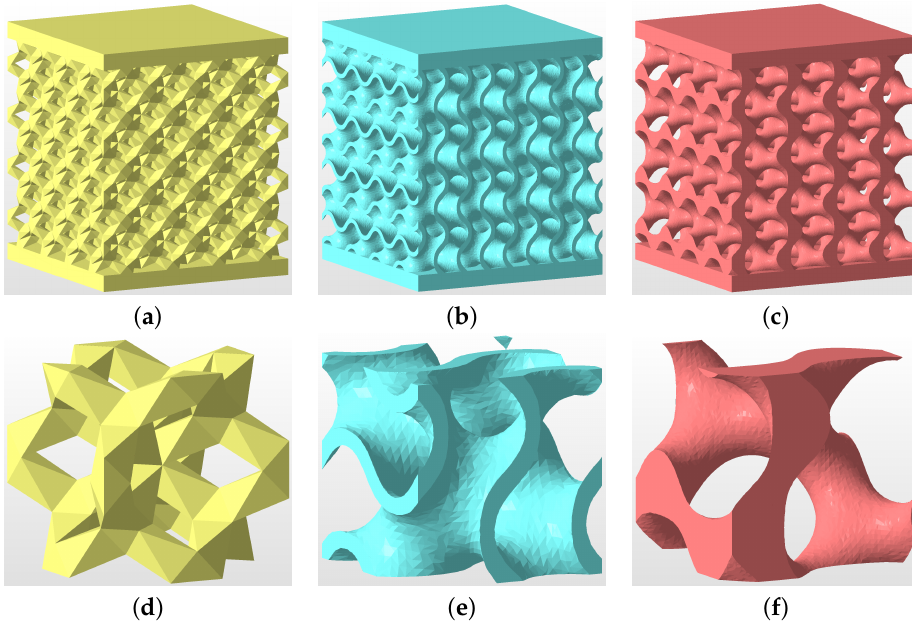
Figure 17. ( a – c ) Geometry of specimens tested experimentally in uniaxial compression: ( a ) DT-2, ( b ) GS, ( c ) GT; ( d – f ) basic unit cells: ( d ) DT-2, ( e ) GS, ( f )